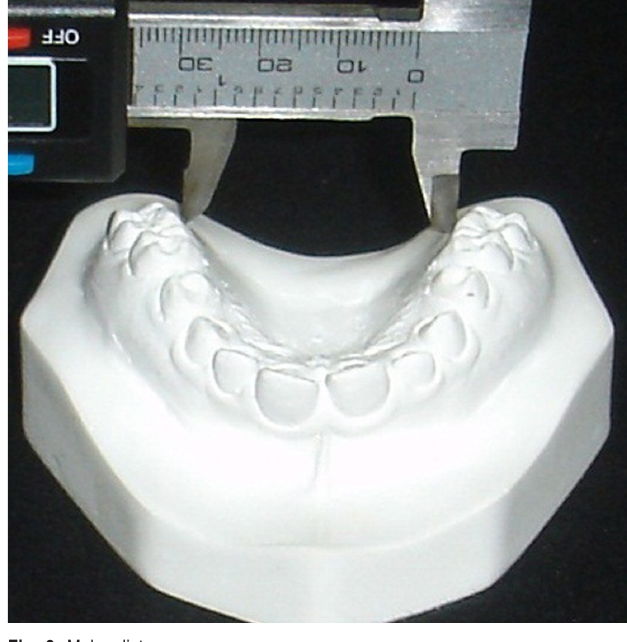
Fig. 6. Second premolar distance